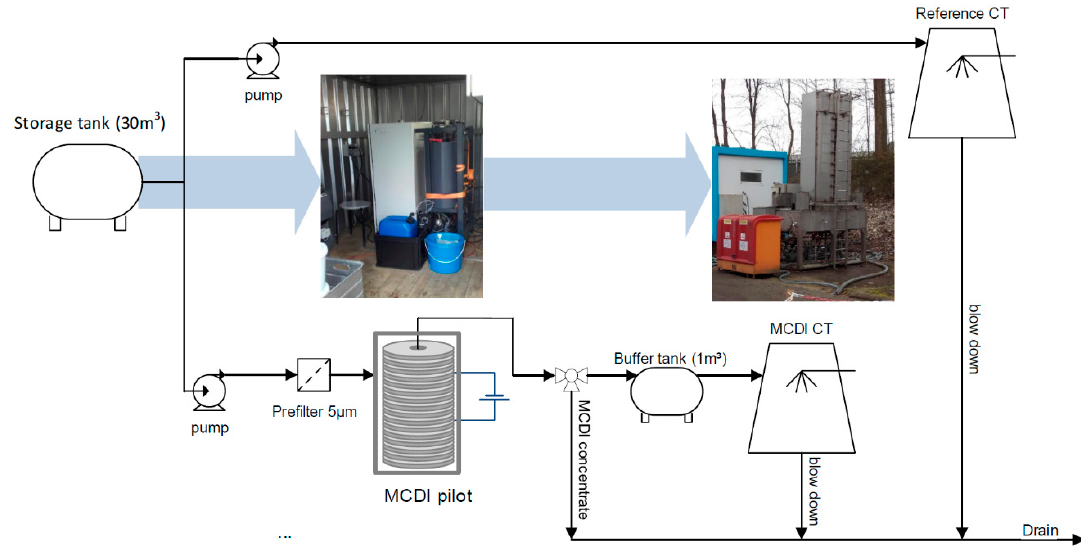
Figure 6. Schematic overview of the MCDI-CT pilot installation. MCDI container with inside view ( left ) and Merades cooling towers and peripheral equipment ( right ).